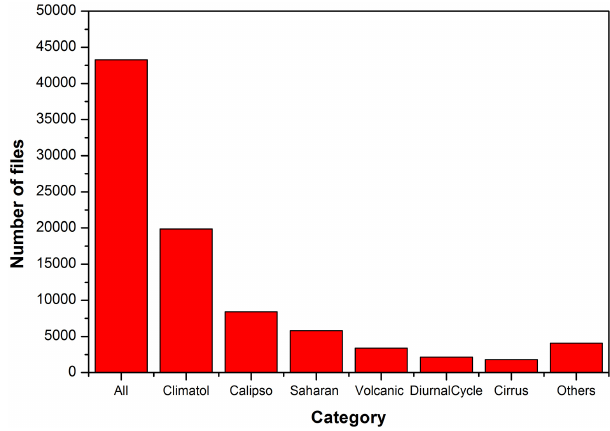
Figure 6. EARLINET database: number of registered external users (a) ; number of files uploaded to the database as of 31 Decem- ber 2013 (b) ; number of files downloaded from the EARLINET database (c) . Public access to the database, through the user web interface, started in April 2010.